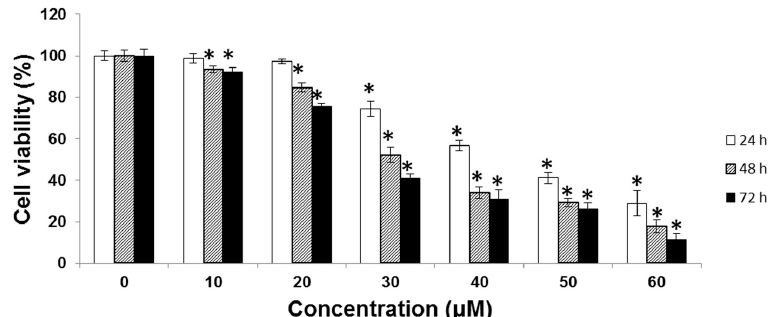
Figure 2. SK-Hep-1 cells (2 ˆ 10 4 cells/well) were treated with various concentrations of UA (0, 10, 20, 30, 40, 50, and 60 µ M) for 24, 48, or 72 h. Cell viability was measured using the MTT assay. The cytotoxicity of UA in SK-Hep-1 cells was dose-dependent. Each point is the mean ˘ SD of three 30, 40, 50, and 60 μ M) for 24, 48, or 72 h. Cell viability was measured using the MTT assay. The experiments. * indicates significant difference from control, p <